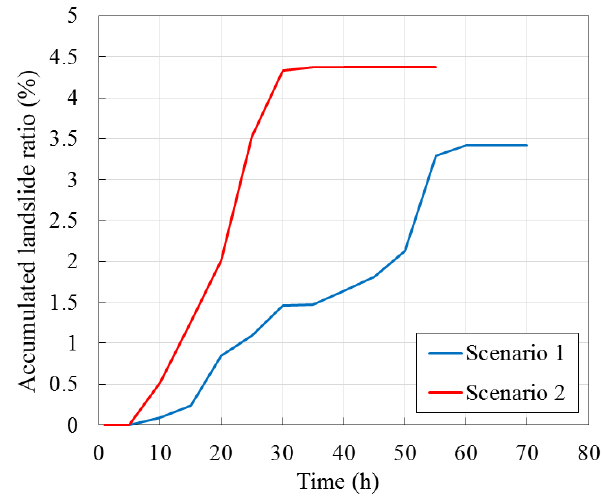
Figure 7. Accumulated landslide ratio vs. time for scenarios 1 and 2 (landslide rate was calculated using the area of FS < 1 over the whole area of the